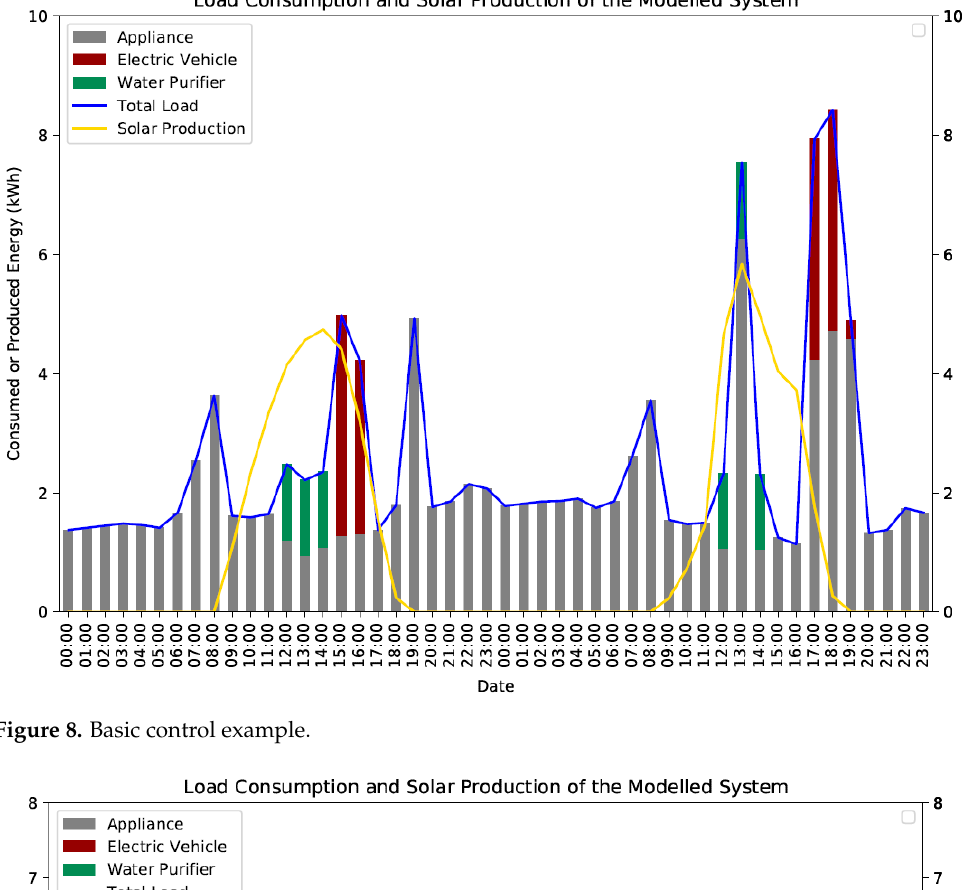
Figure 8. Basic control example.